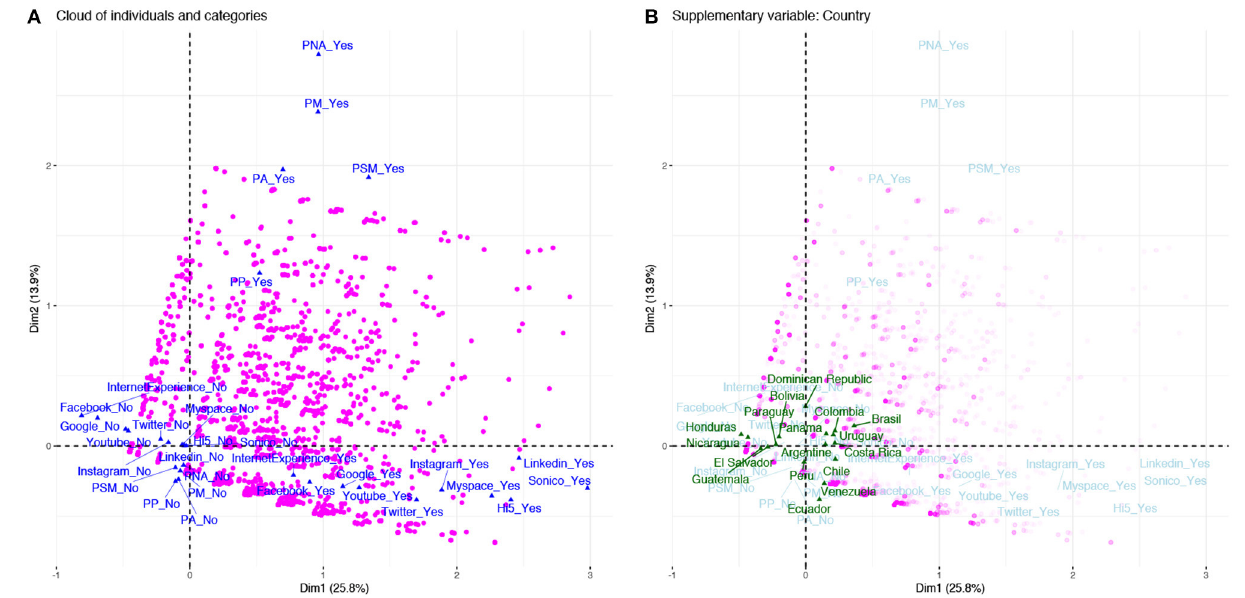
FIGURE 4 | Representation of individuals according active and supplementary variables ( n (magenta) and categories cloud (blue); (B) Superimposed representation of supplementary variable Country (green).